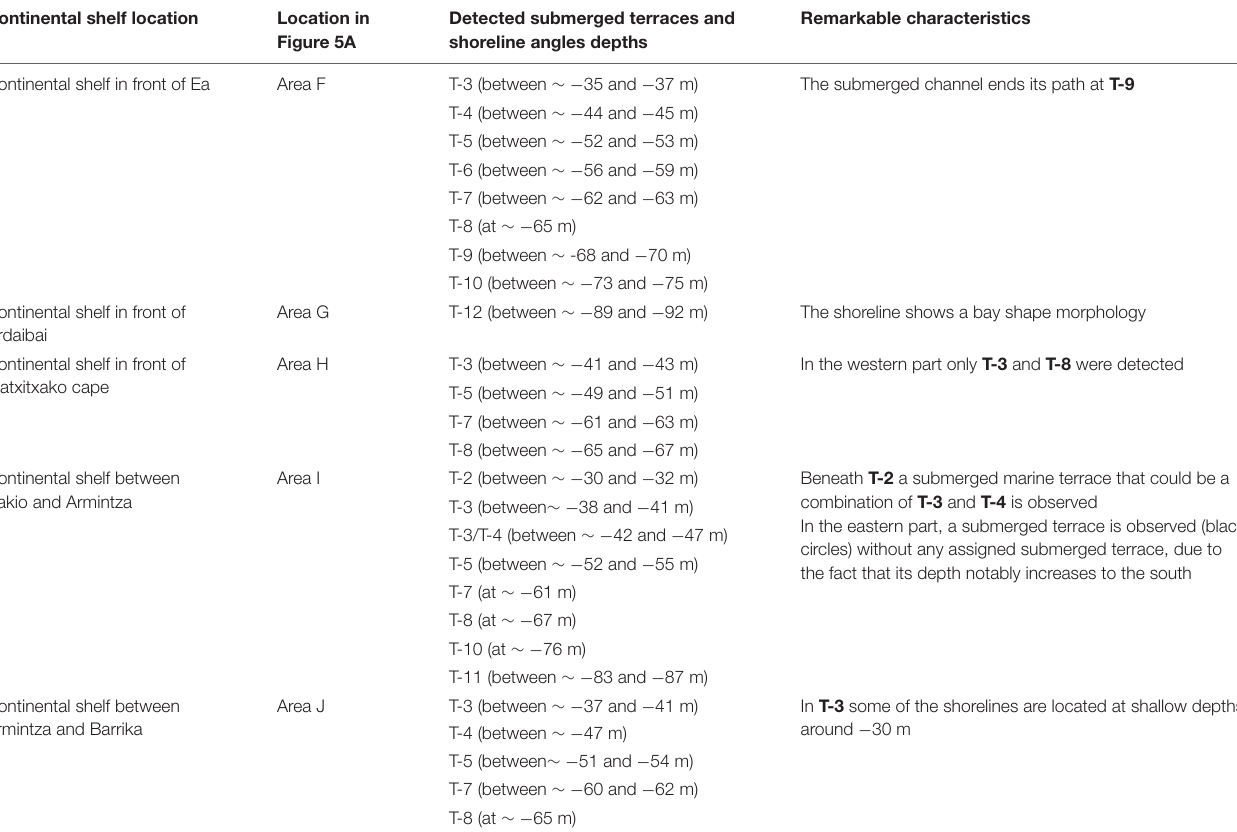
TABLE 2 | Submerged marine terrace distribution from Ea to Barrika in segments of the continental shelf with the most remarkable